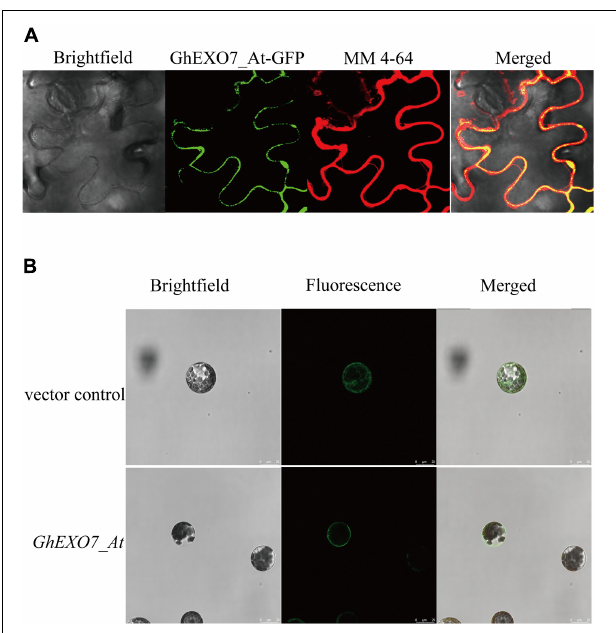
FIGURE 6 | Subcellular localization of GhEXO7_At. (A) The Brightfield, GhEXO7_At-GFP Fluorescence, MM 4-64, and Merged images of infiltrated N. benthamiana leaf epidermal cells are shown. (B) The empty vector (control) and the GhEXO7_At-GFP vector were introduced into Arabidopsis mesophyll protoplasts. The Brightfield, Fluorescence (GFP), and Merged images are shown.